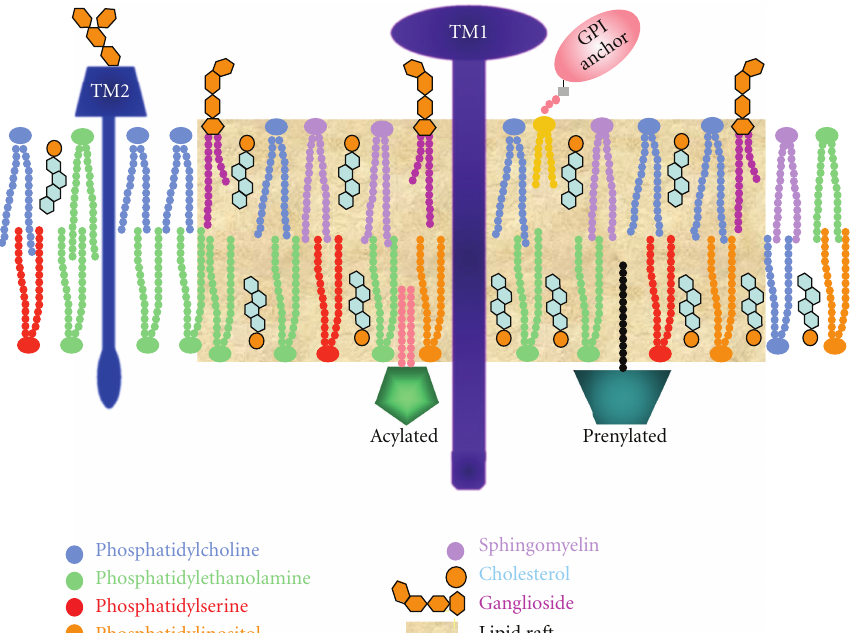
Figure 1: Diagrammatic representation of a lipid raft. Lipid rafts are enriched in cholesterol, sphingolipids, and gangliosides. GPI anchored proteins, sphingomyelin, phosphatidylcholine and gangliosides are present in the outer membrane leaflet. Prenylated proteins, acylated proteins, phosphatidlyserine, and phosphatidylethanolamine are present in the inner leaflet. Cholesterol is present in both leaflets and functions as a space filling molecule under the sphingolipid head groups. TM1, TM2, Transmembrane proteins 1 and